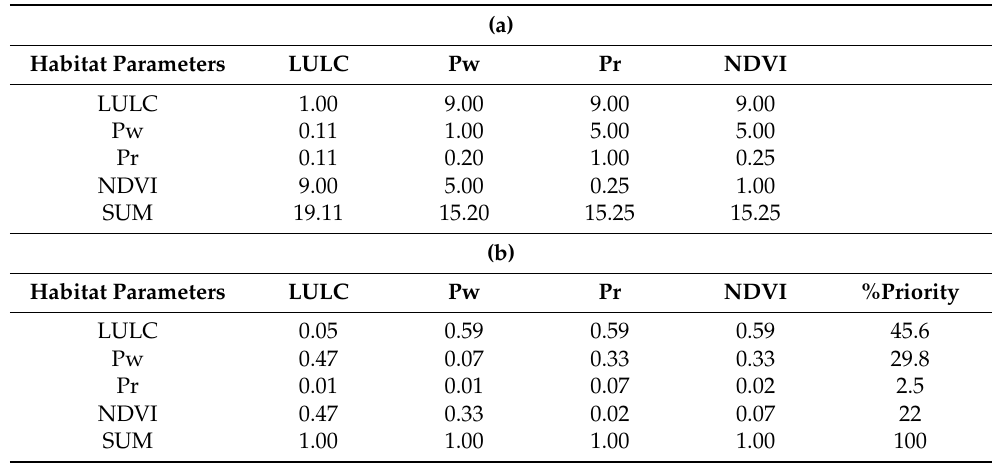
Table 3. ( a ) Estimated weights for elephant habitat parameters that were used in the Analytical Hierarchy Process (AHP) model [58]. The table shows a pairwise comparison matrix. Decimal values are reciprocals. LULC = land-use/land-cover change, Pw = proximity to water, Pr = proximity to roads, NDVI = Normalized Difference Vegetation Index. ( b ) Normalized values to determine the propriety vector or weights of habitat parameters in the model. The priority in % (normalized principal Eigen vector) was calculated by determining the means of the rows of the normalization table.